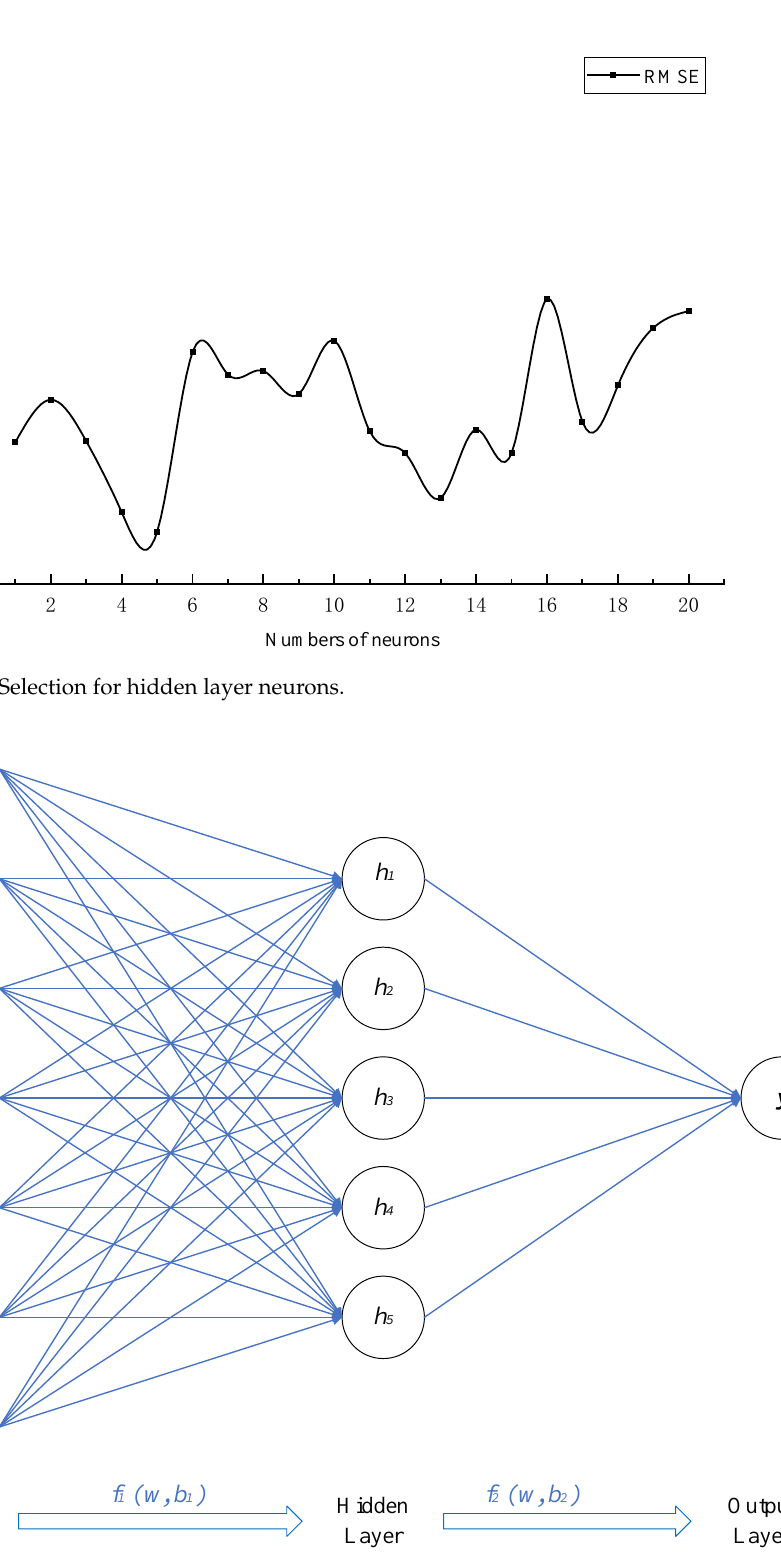
Figure 6. Back-propagation neural network ( PC : principal component; h : hidden neuron; y : out- put).